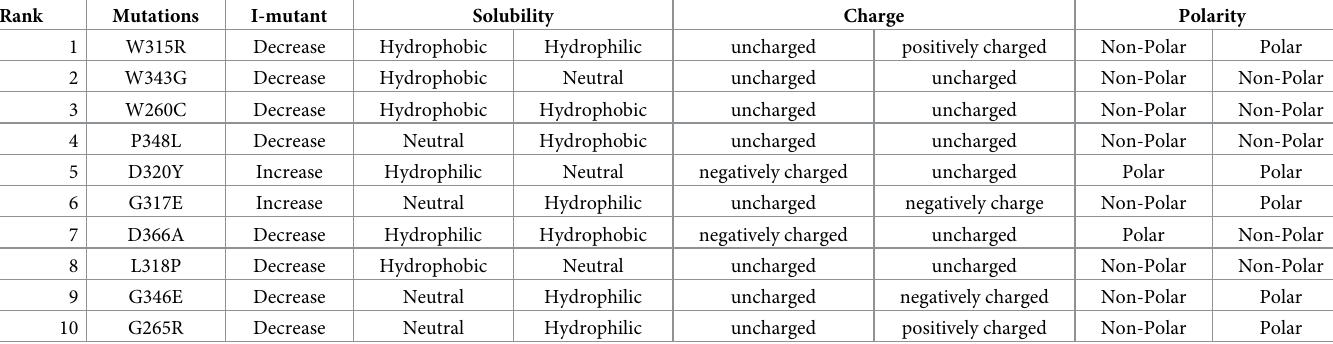
Table 5. Effect of deleterious SNPs on protein stability along with their solubility, charge and polarity properties. Rank